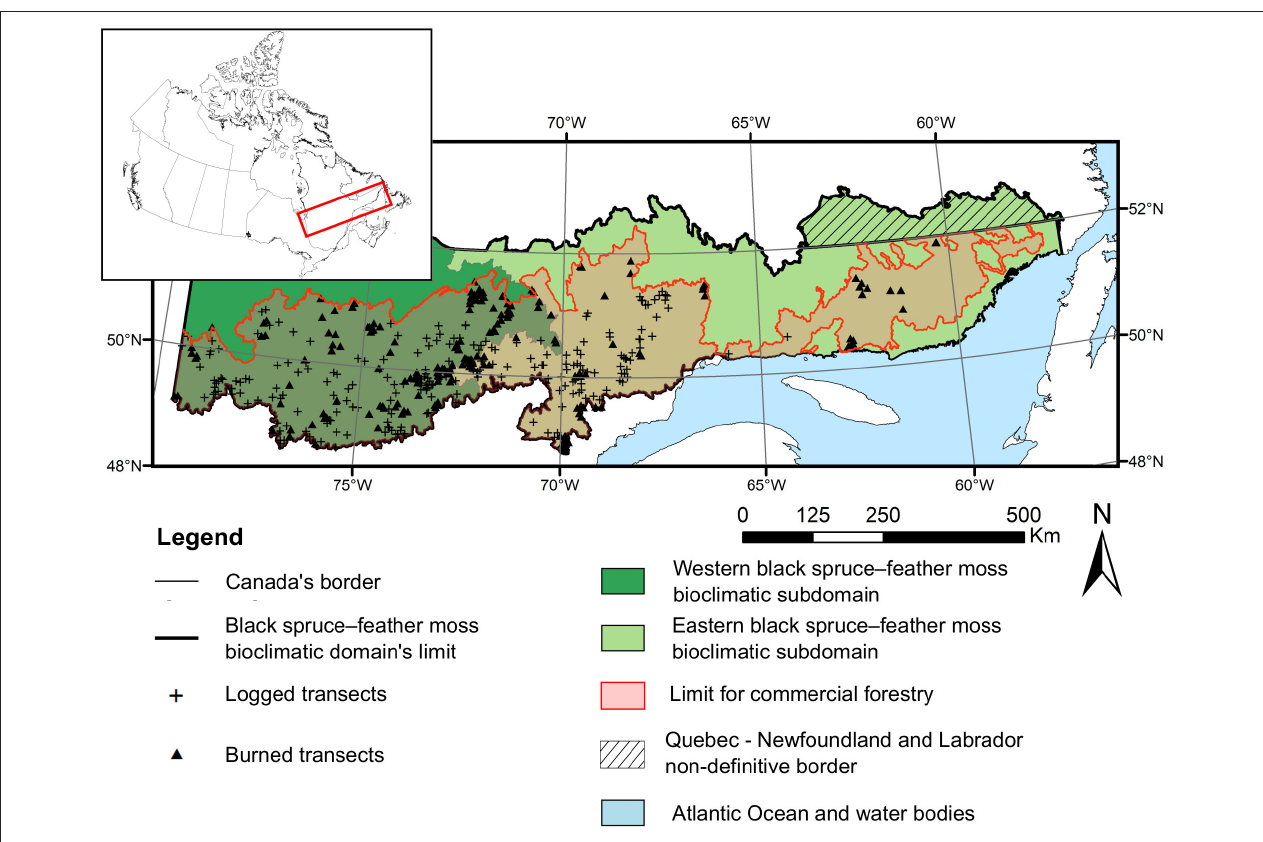
FIGURE 1 | Map of the study territory. The insert map indicates its location in